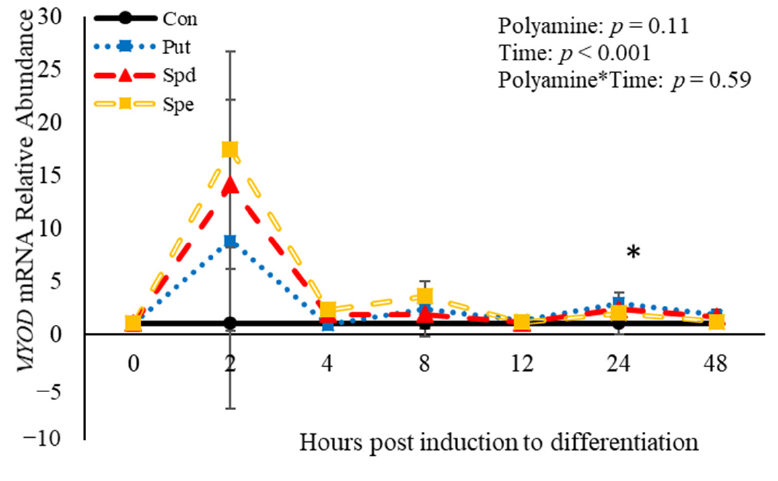
Figure 6. Relative mRNA abundance of paired box transcription factor 7 ( PAX7 ; ( A ) , myogenic factor 5 (MYF5; ( B ), and myogenic differentiation factor 1 (MYOD ; ( C ) from primary bovine satellite cells cultures following treatment with 2 mM putrescine (PUT), 1.5 mM spermidine (SPD) or 0.5 mM spermine (SPE). Cultures were grown to 80% confluency and treated with DMEM/3% horse serum and 2 mM PUT, 1.5 mM SPD, or 0.5 mM SPE. Abundance was measured 0, 2, 4, 8, 12, 24 and 48 h after treatment, as described in the Materials and Methods. The main effects of polyamine, time and polyamine*time in mRNA abundance were analyzed as repeated-measures. Data represent relative mRNA abundance normalized against 18S abundance and are presented as LS mean ± SEM from six separate replicates utilizing BSCs isolated BSCs isolated from at least three different animals. Differences ( p < 0.05) between polyamines and the control cultures are indicated by a * at that particular time point.